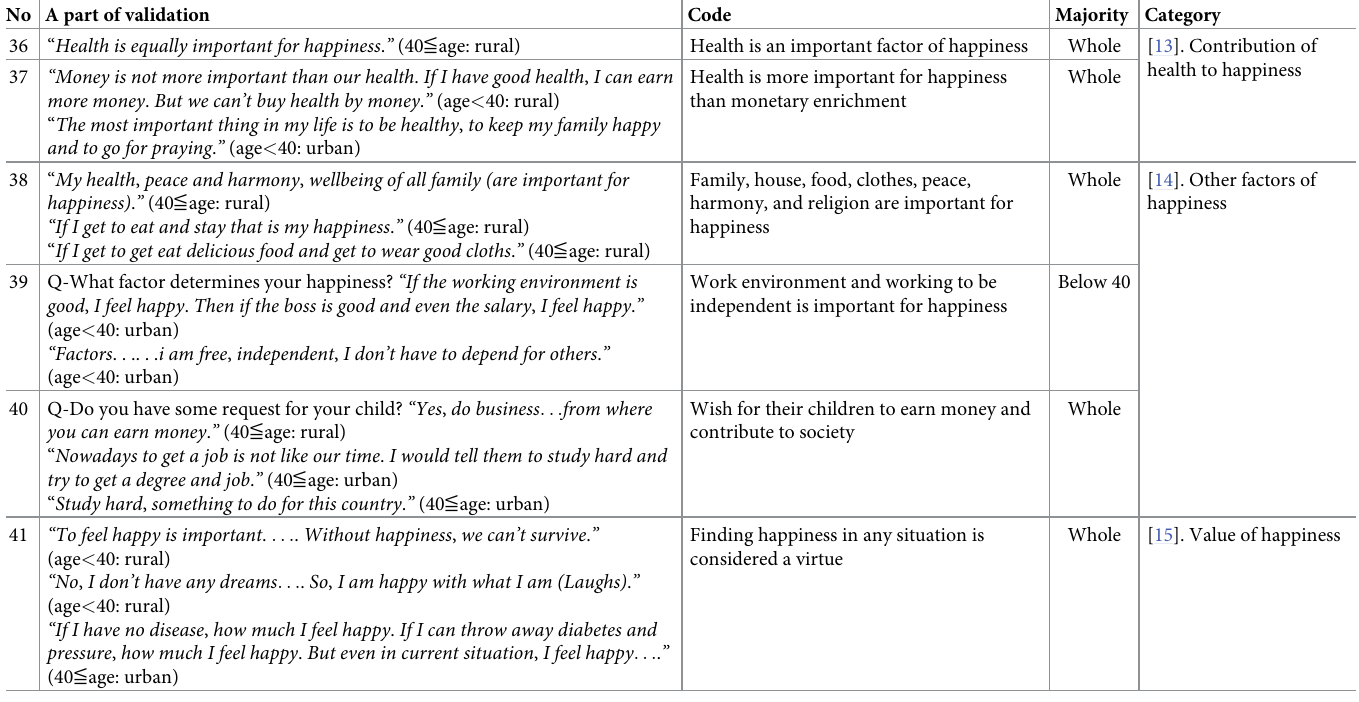
Table 9. Theme VI: Happiness: Validation, code, categories and themes. No A part of